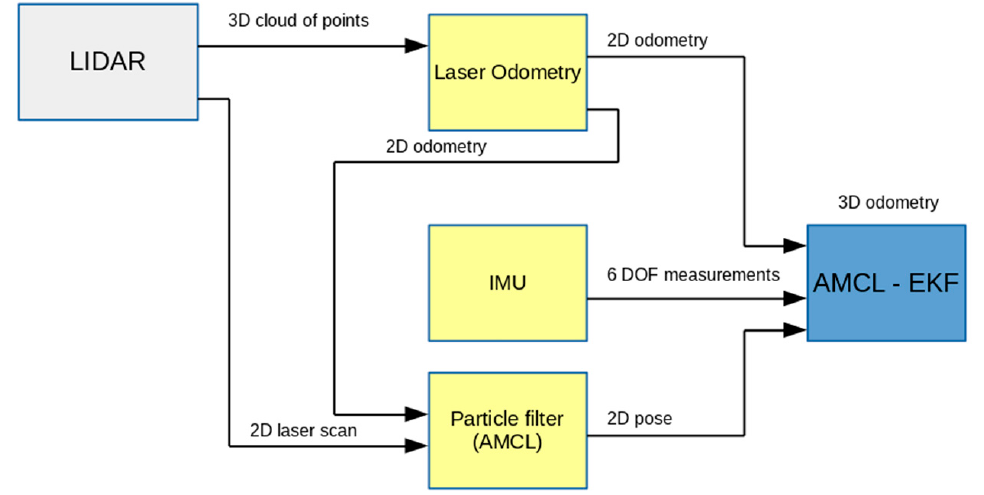
Figure 1. Schematic diagram of local 3D pose estimation by AMCL-EKF algorithm.